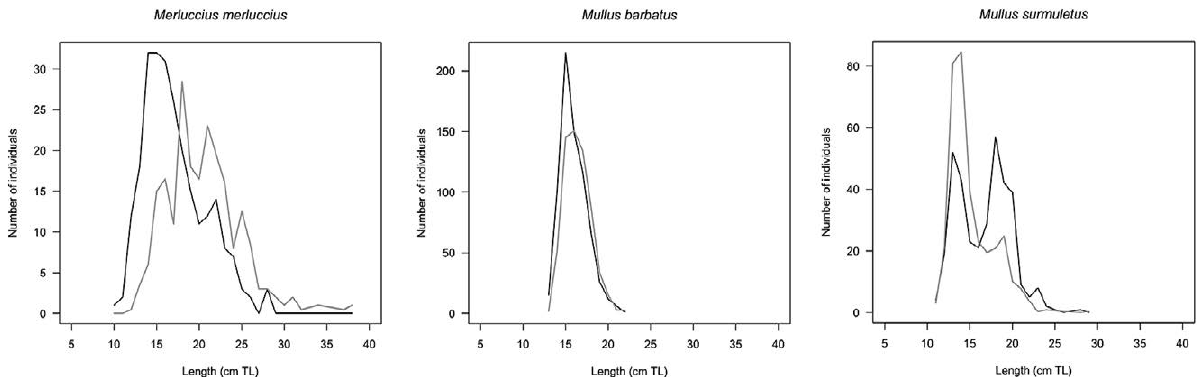
Fig. 3. – Length frequencies of the target species. Black line, standard configuration with a 53-mm diamond mesh; grey line, experimental trawl fitted with 50-mm T90 mesh